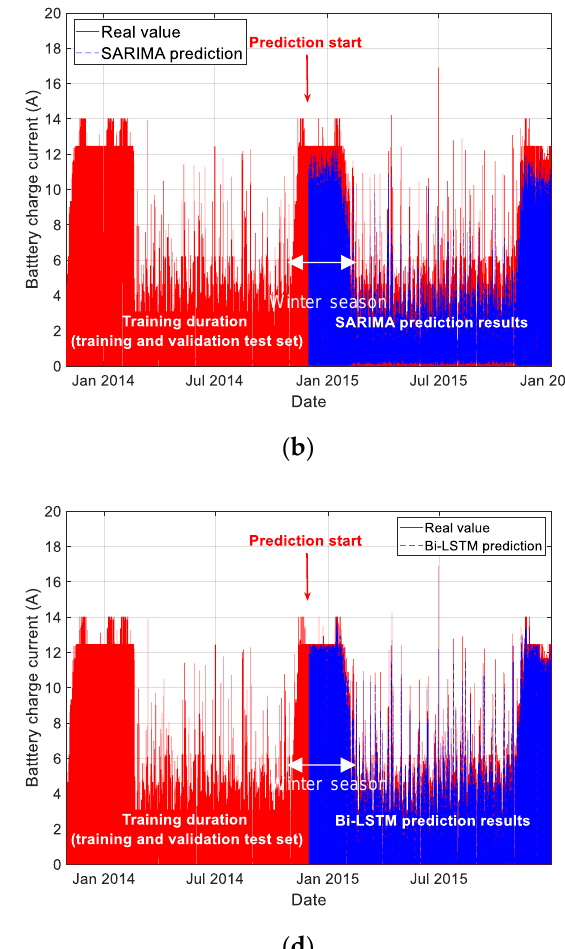
Figure 11. KOMPSAT-3A enlarged battery current prediction results: ( a ) discharge current; ( b ) charge current.